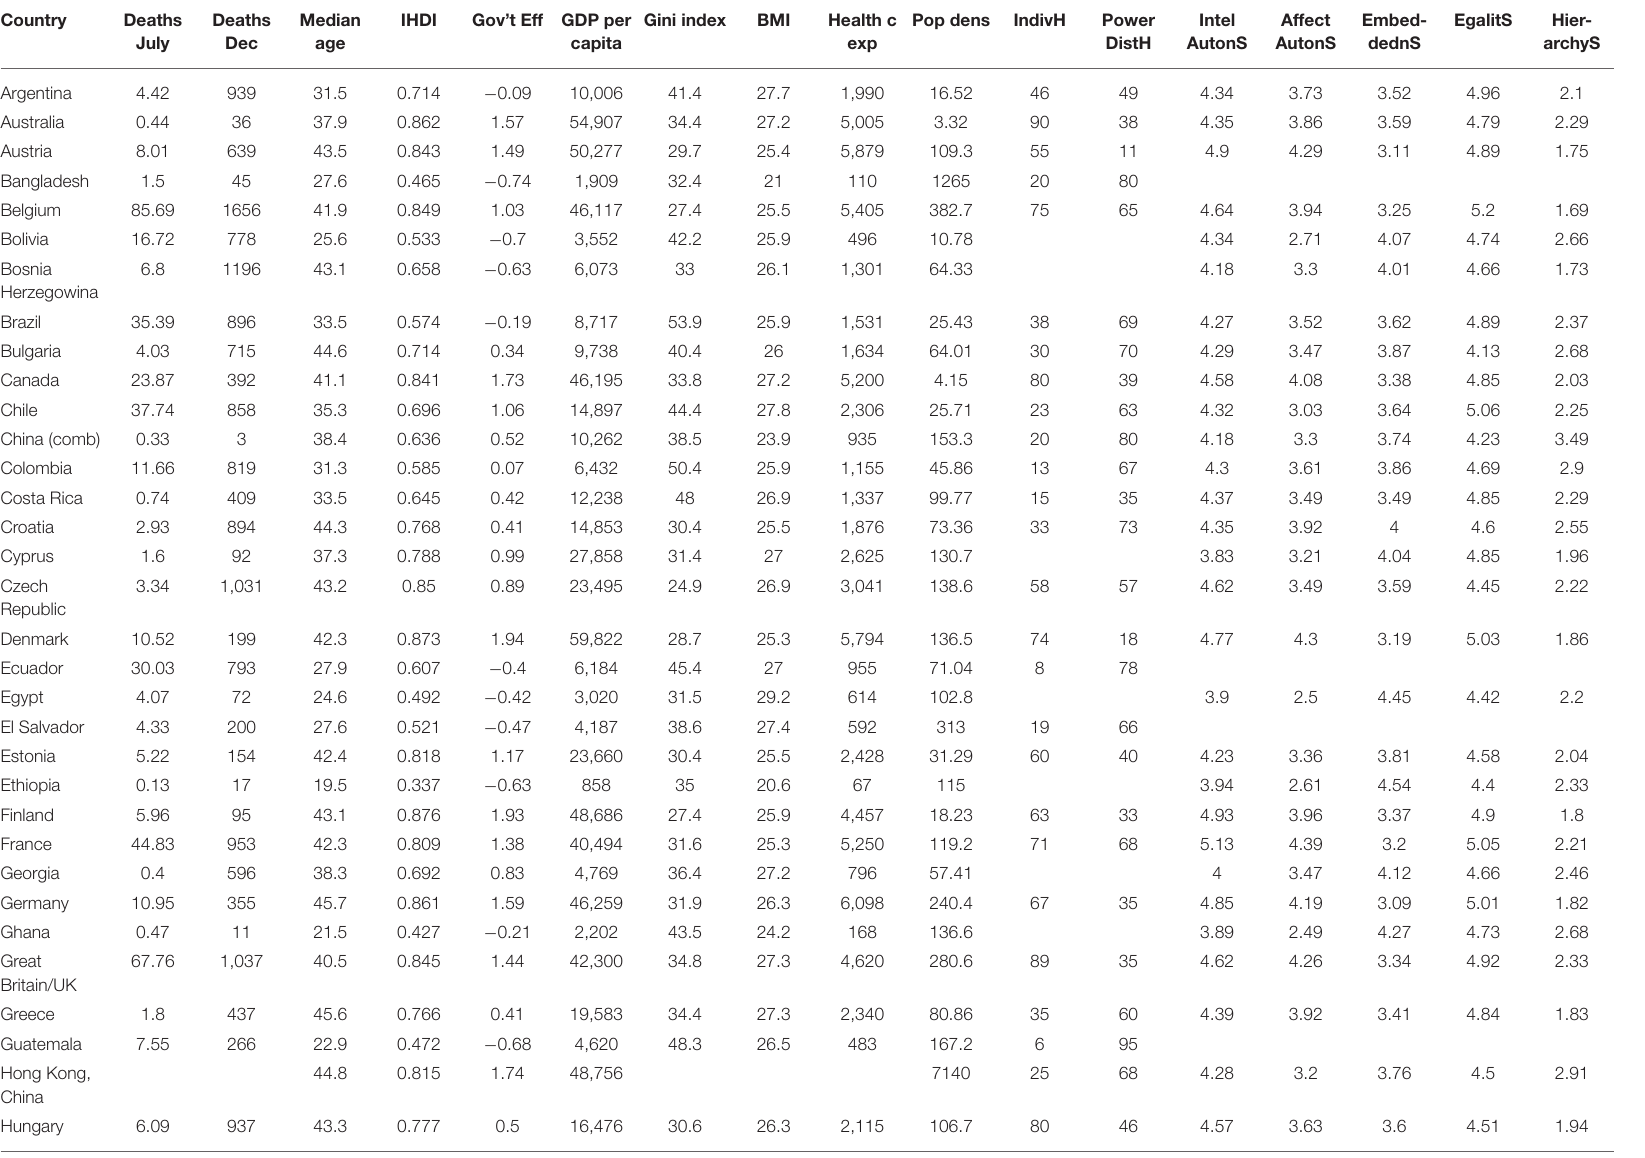
TABLE 1 | Descriptive statistics for study variables in the 88 countries.